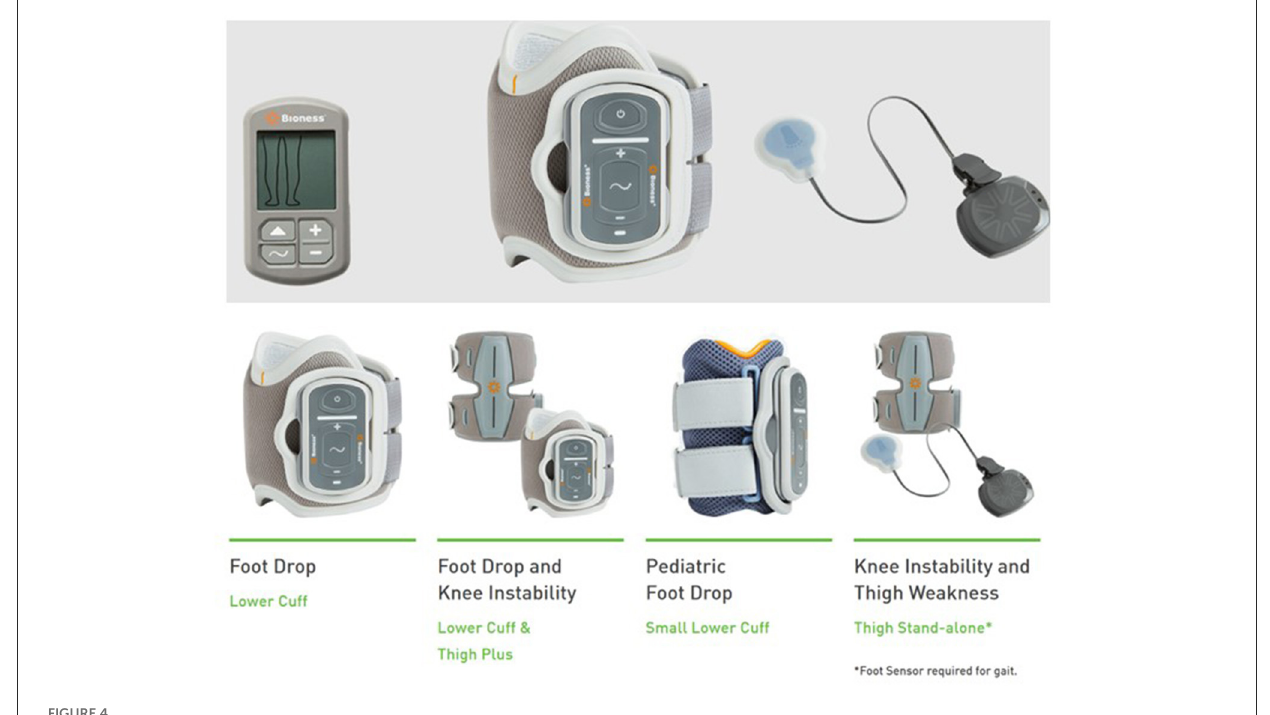
FIGURE4 FES of foot (Bioness L300 Go).